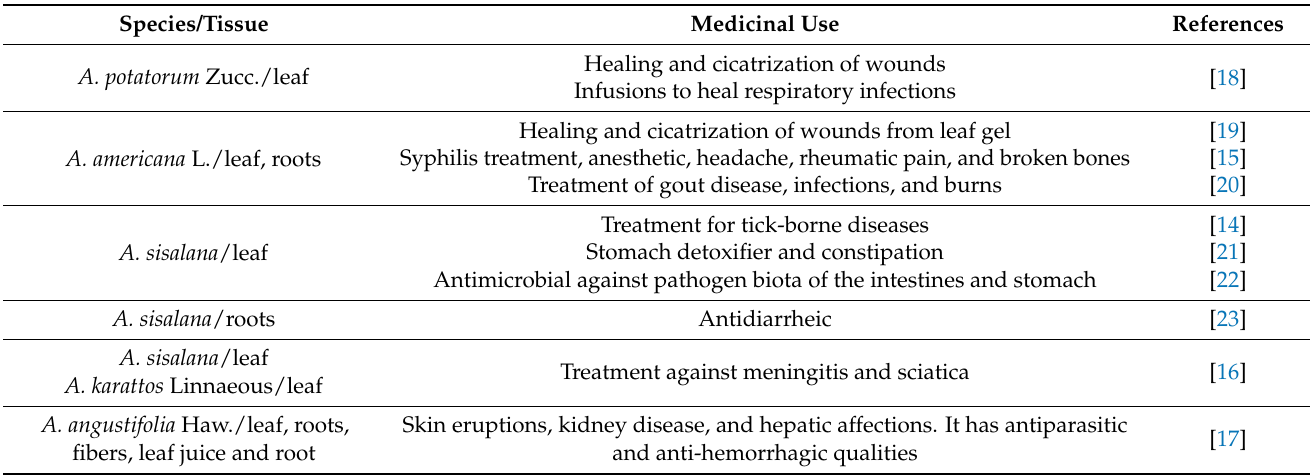
Table 1. Medicinal uses of the Agave